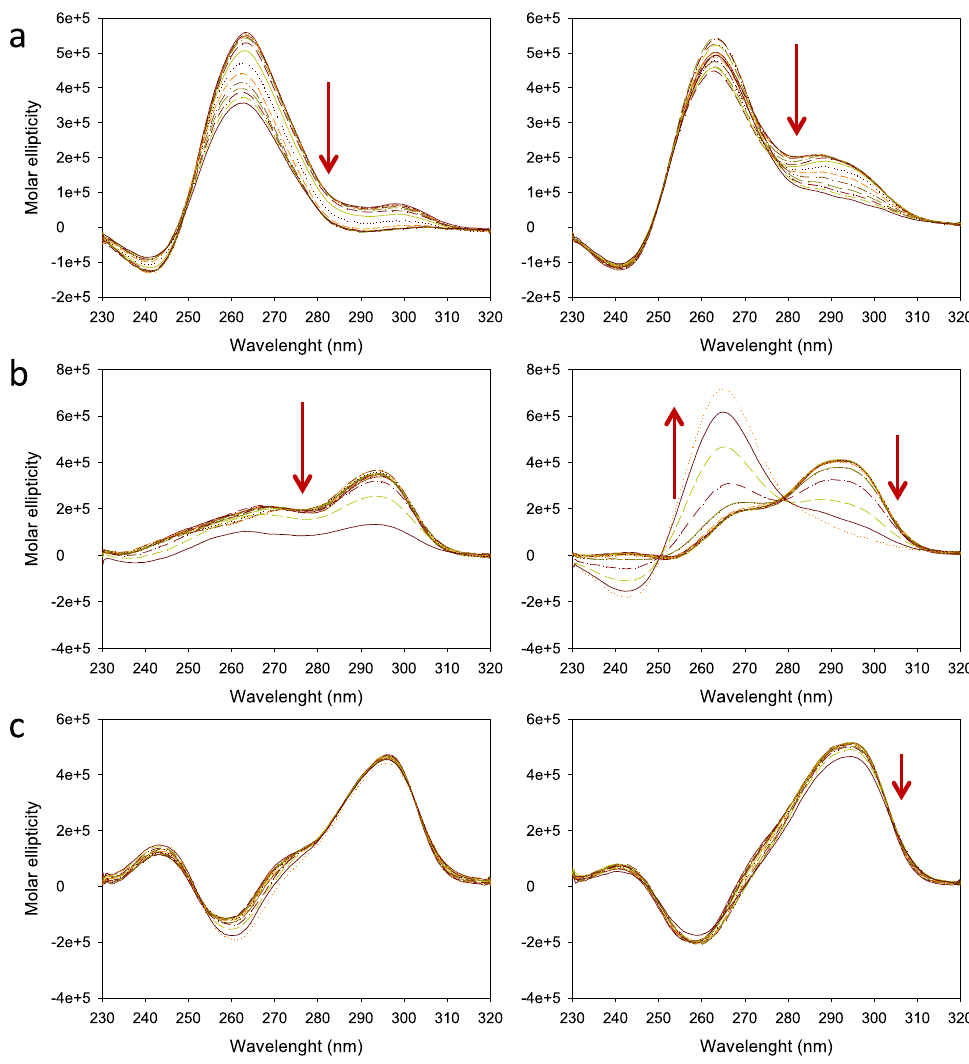
Figure 1. Thermal unfolding of un3 parallel G4 ( a ), gp054a hybrid G4 ( b ), un2 antiparallel G4 ( c ) (4 μ M) in 100 mM K + in the absence (left panel) or presence (right panel) of 16 μ M c-exNDI. Thermal unfolding was recorded over a temperature range of 20–90 °C with temperature increase of 5